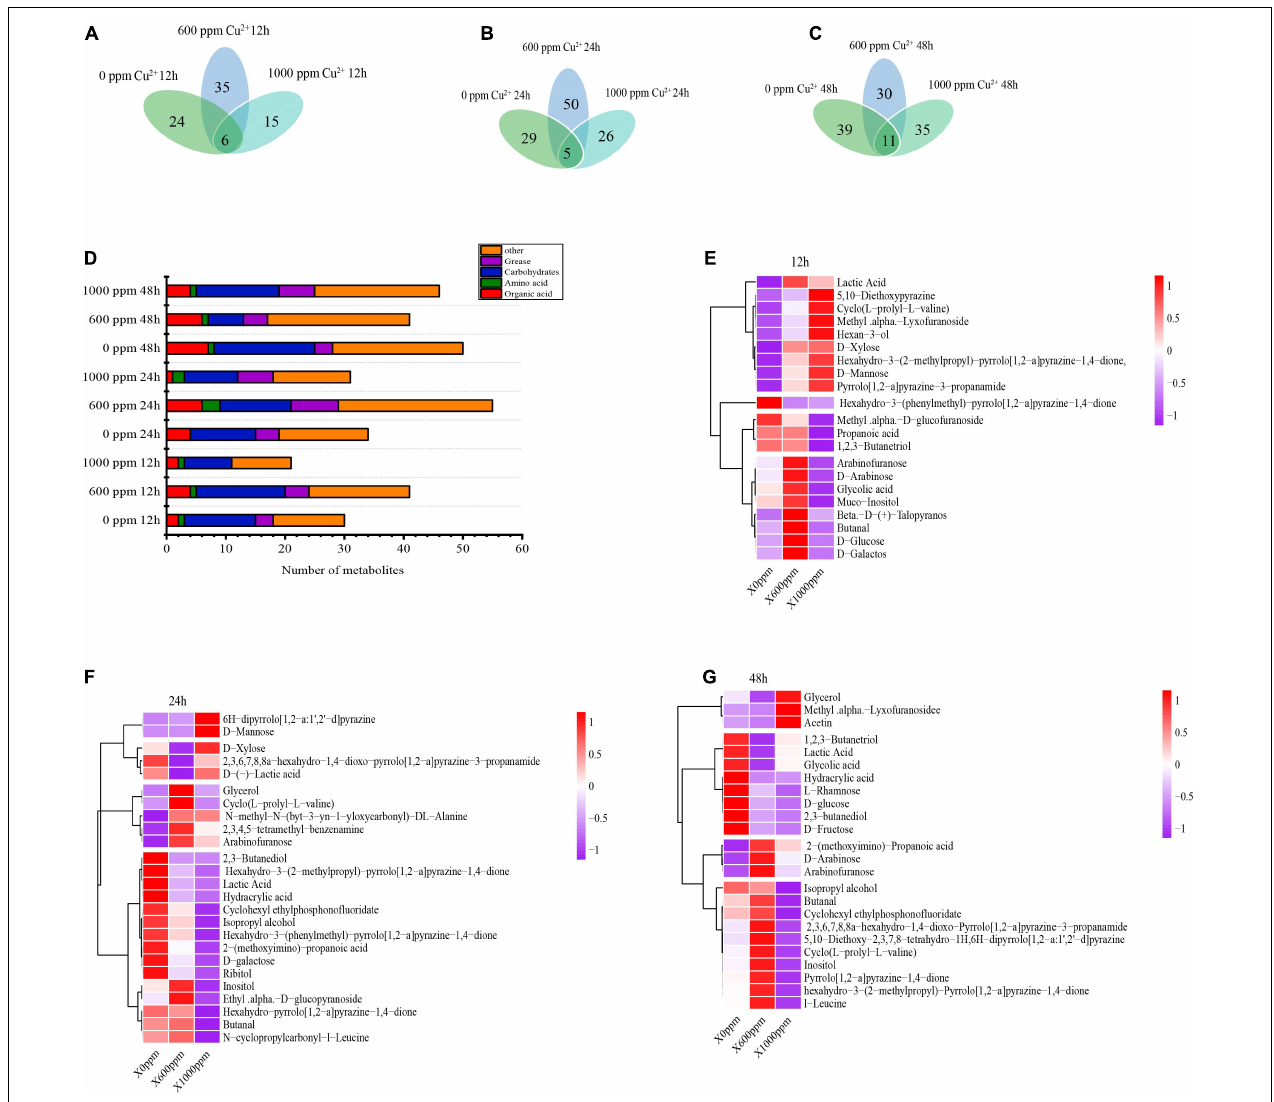
FIGURE 4 | Effects of copper ion stress on the metabolism of GXDK6. Metabolites of GXDK6 under copper ions stress for (A) 12, (B) 24, and (C) 48 h. (D) Classification analysis of metabolites. Heatmap analysis of differential metabolites under copper ions tress for (E) 12, (F) 24, and (G) 48